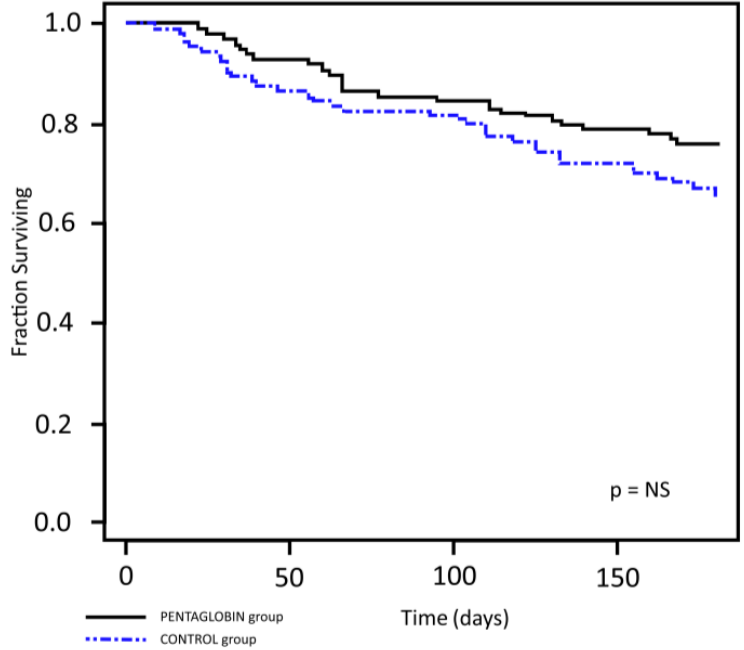
Figure 3. Kaplan-Meier curves for overall survival (OS) in the Pentaglobin group and the control group. In contrast, Kaplan–Meier survival analysis calculated for deaths due to infectious complications J. Clin. Med. 2020 , 9 , x FOR PEER REVIEW showed a statistically significant di ff erence ( p = 0.006) (Figure 4).